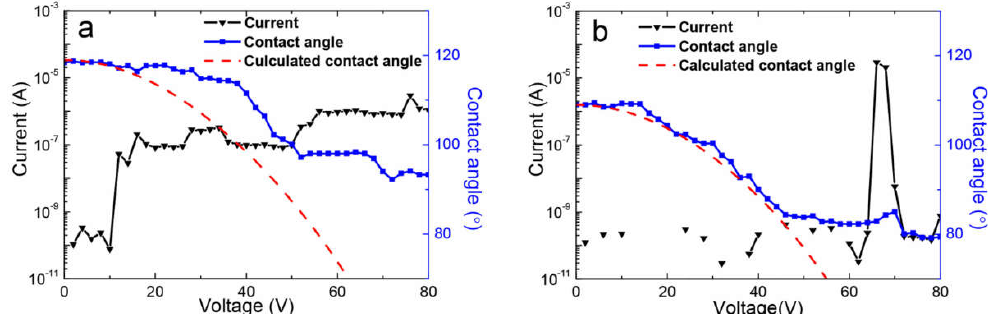
Figure 5. Leakage current and electrowetting measurement of ( a ) Teflon AF coating with a thickness of 0.51 μm and ( b ) Cytop 809A coating with a thickness of 0.51 μm. Measured current in black (left axis) and contact angle data in blue (right axis) with Equation (1) modeled (red dashed line).